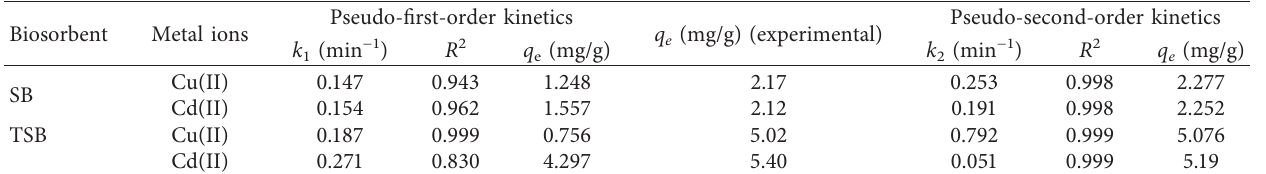
Figure 5: Time interval effect on biosorption of (a) Cu(II) and (b) Table 2: Kinetic parameters for Cu(II) and Cd(II) biosorption.